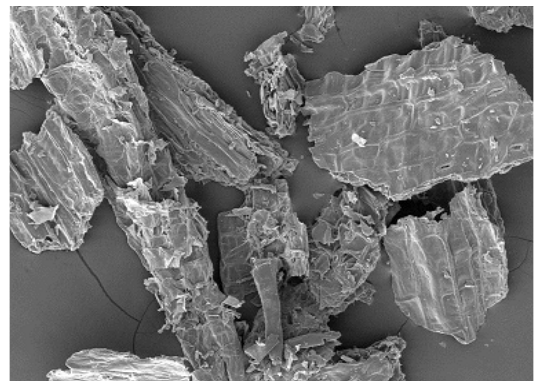
Fig. 5. SEM of corn leaves